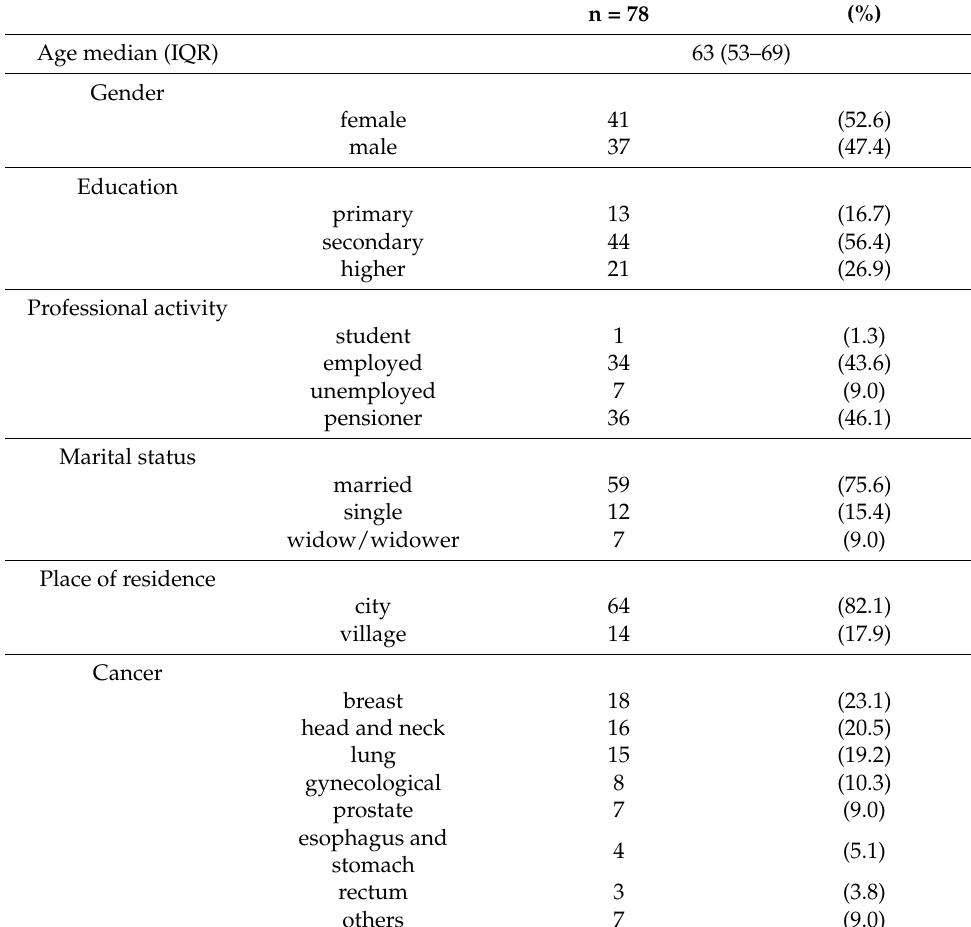
Table 1. Characteristic of